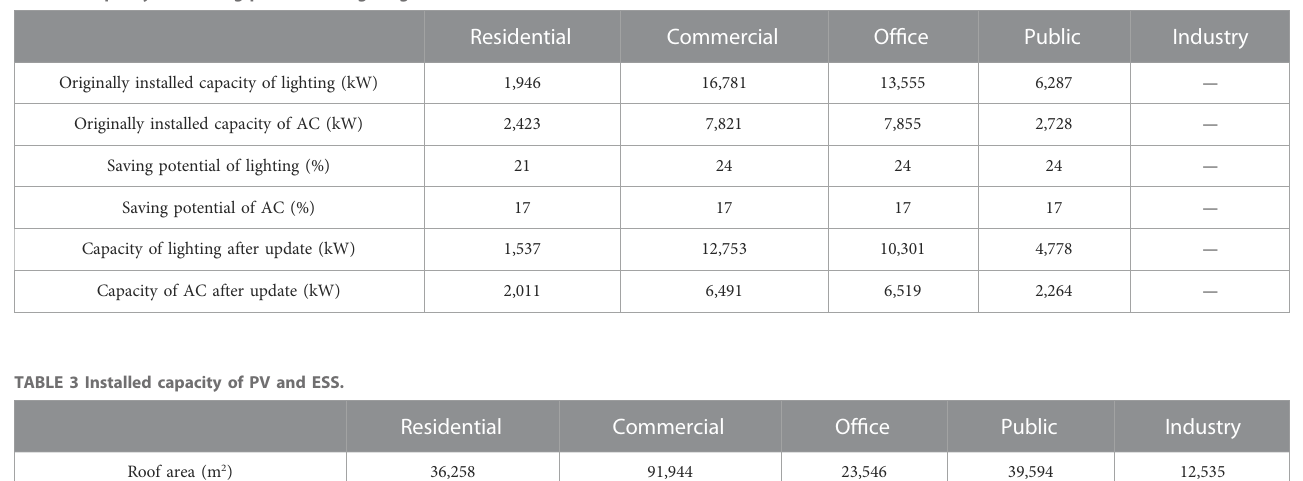
TABLE 2 Capacity and saving potential of lighting and AC.